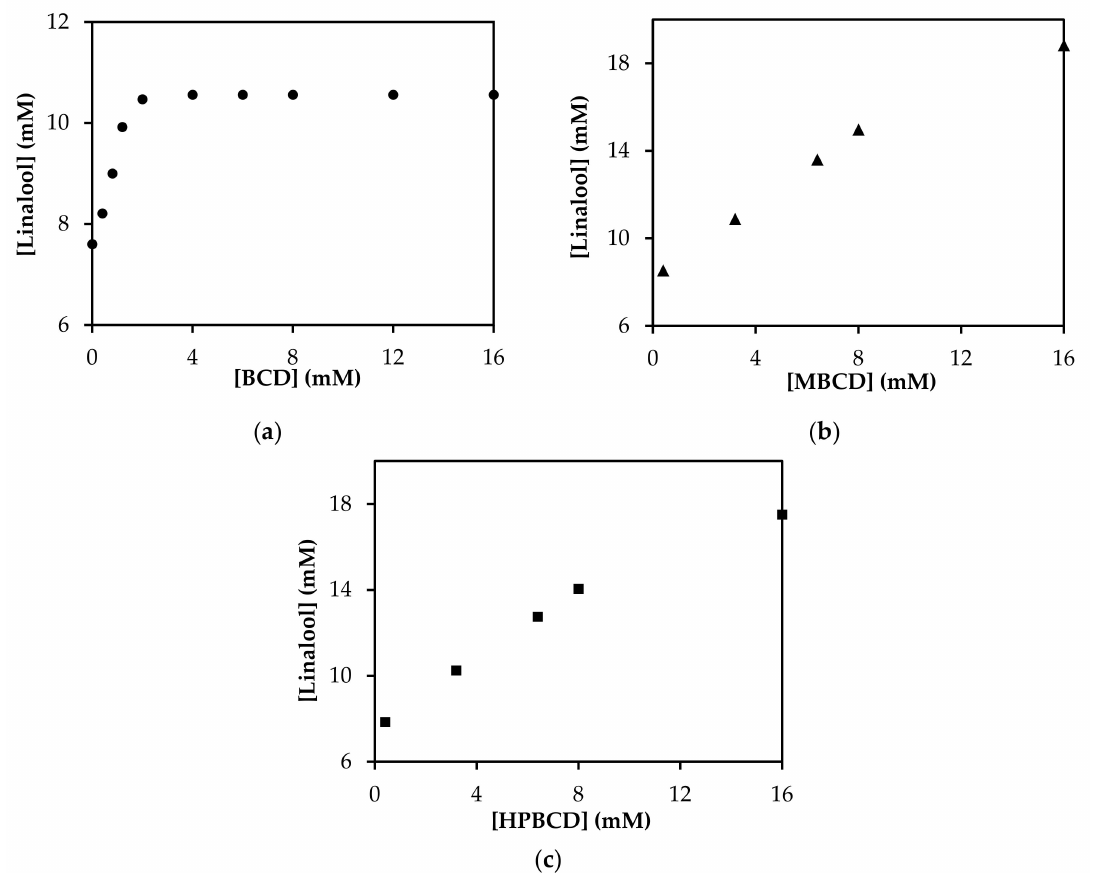
Figure 12. Phase solubility diagrams of ( a ) linalool in BCD solution, ( b ) linalool in MBCD solution, and ( c ) linalool in HPBCD